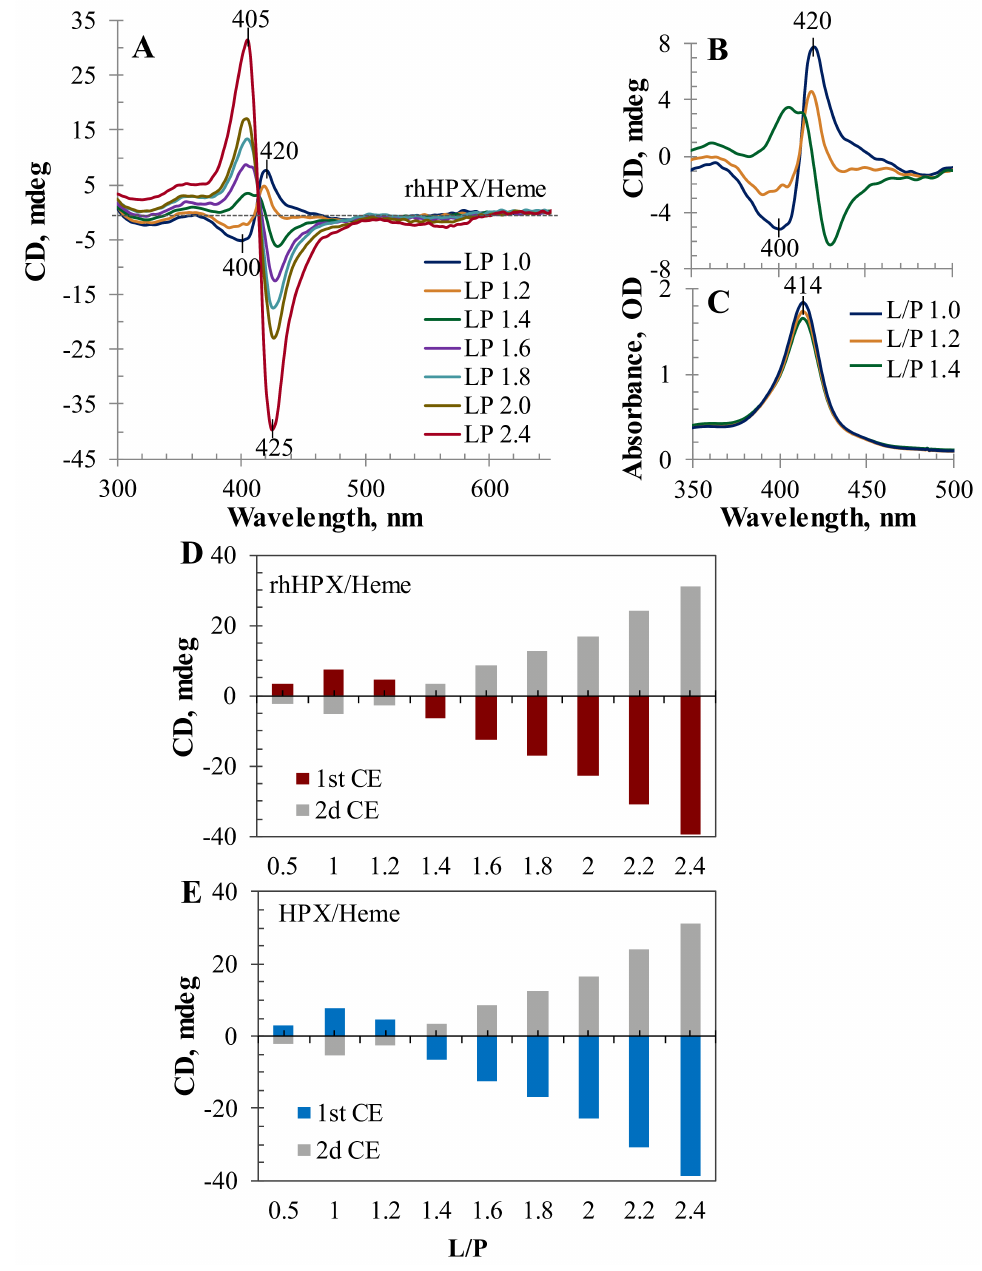
Figure 5. CD titration data for rhHPX and HPX with heme at higher than equimolar L/P. ( A ) Overlay of the induced CD (ICD) spectra of the rhHPX/Heme samples (L/P 1.0–2.4; for clarity, selected spectra are shown); ( B ) ICD spectra of rhHPX/Heme samples at L/P 1.0, 1.2, and 1.4, and ( C ) complementary UV/Vis spectra; ( D , E ) ICD spectral changes plotted as the observed 1st CE and observed 2nd CE versus increasing content of heme (L/P), respectively, for rhHPX ( D ) and plasma HPX ( E ). A transition through an intermediate state with a shortened ICD amplitude (orange trace) and an inverse +/ − ICD couplet is indicative of a strong opposite exciton